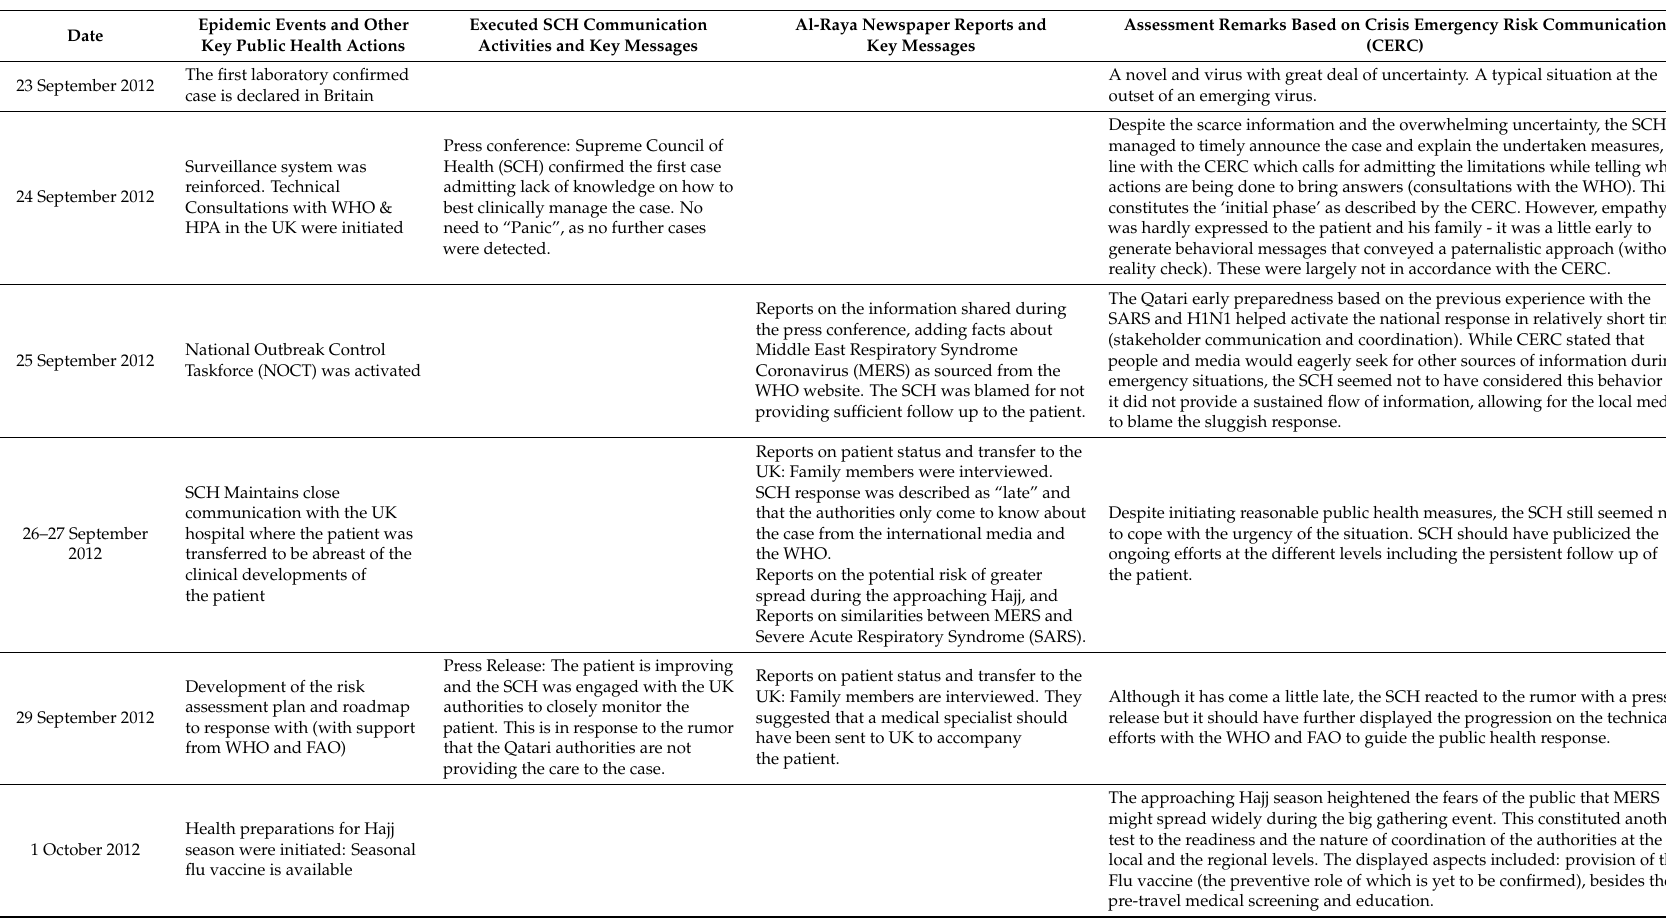
Table 1. First phase of the epidemic (23 September–19